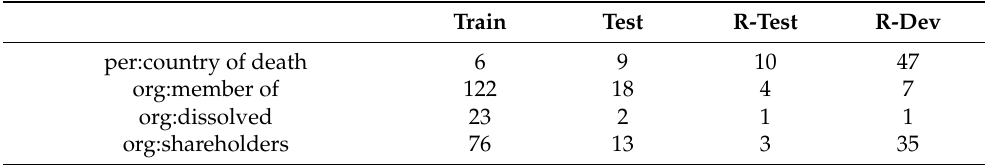
Table A3. MCs distribution. Train and Test is that of TACRED and R- indicates Revised TACRED. Aug. indicates augmentation which of values was added to the original training dataset for our final model